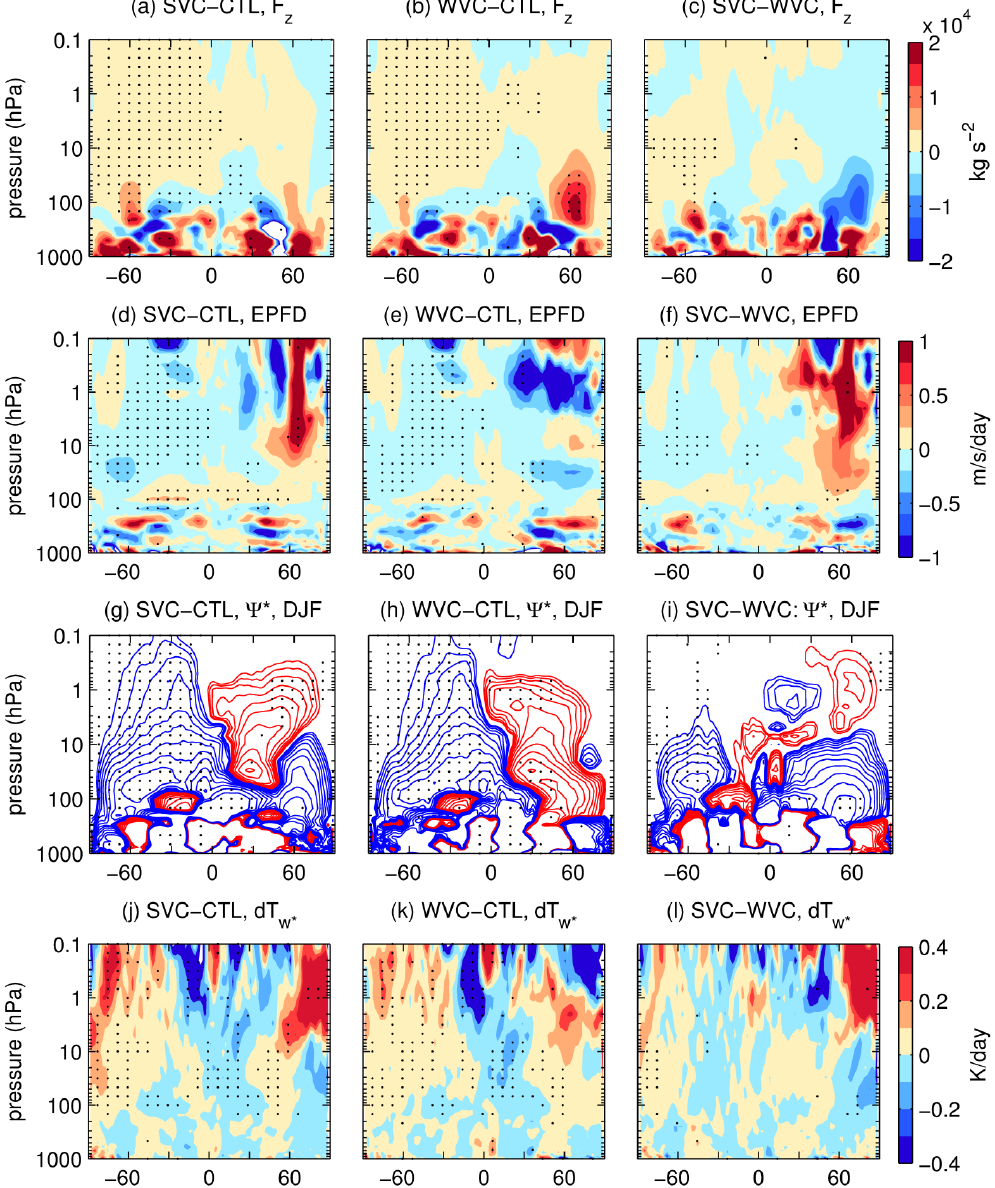
Figure 12. Selected TEM diagnostics for the SVC and WVC forced ensembles. Shown are DJF anomalies for the (left) SVC and (middle) Figure 12: Selected transformed Eularian mean diagnostics for the SVC and WVC forced ensembles. 823 WVC ensembles, and (right) the difference between the two ensembles for (a, b, c) vertical component of EP-flux, (d, e, f) EP-flux divergence, Shown are DJF anomalies for the (left) SVC and (middle) WVC ensembles, and (right) the difference 824 (g, h, i) residual circulation streamfunction and (j, k, l) heating due to residual vertical advection. Stream function contours in panels (g, h, between the two ensembles for (a,b,c) vertical component of EP-flux, (d,e,f) EP-flux divergence, (g,h,i) 825 i) are red for positive values and blue for negative values, and are log-spaced ranging from 1 to 100kgm − 1 s − 1 residual circulation and (j,k,l) heating due to residual vertical advection. Stream function contours in 826